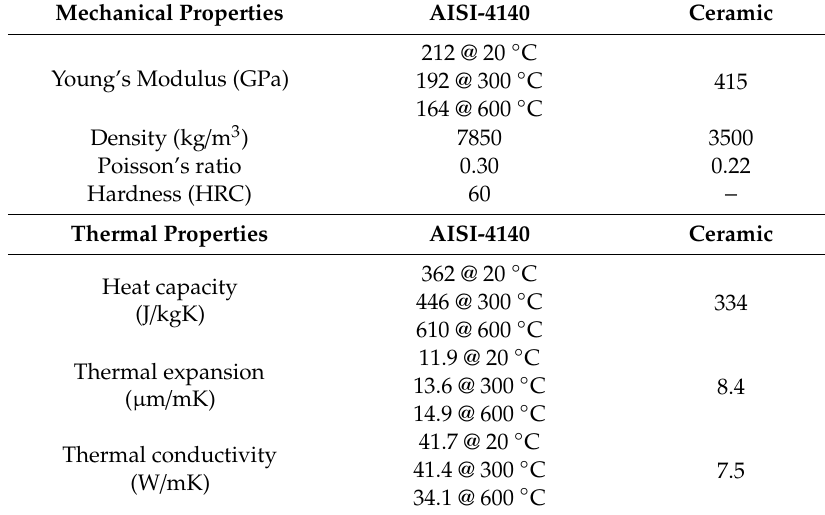
Table 3. Thermo-mechanical properties for the ceramic insert [31] and steel workpiece [13]. Mechanical